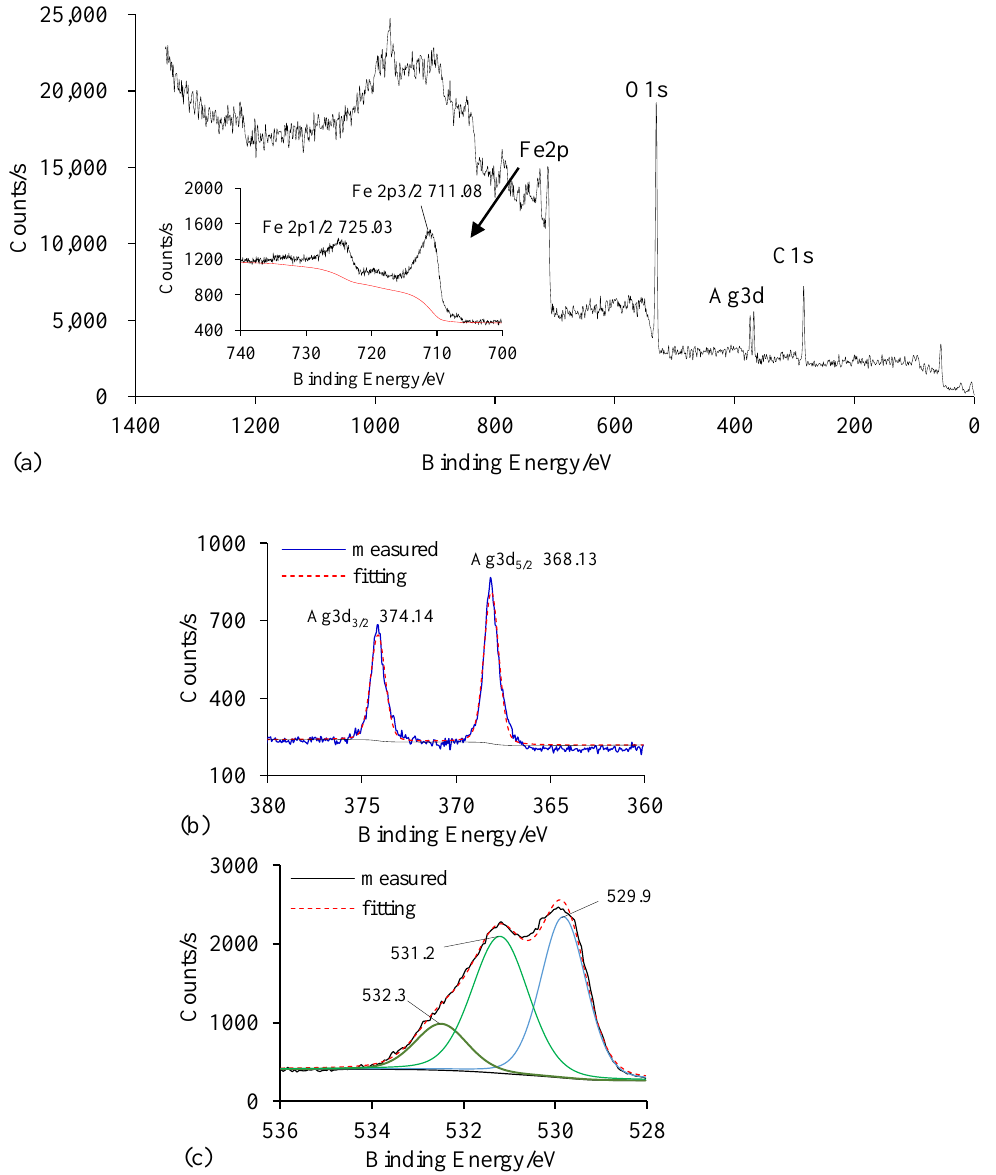
Figure 2. XPS wide-scan and high-resolution spectra of fresh Ag/Fe particle with 0.4 wt.% Ag loading. ( a ) Wide scan spectra of Ag/Fe; ( b )Ag 3d core level XPS spectra of Ag/Fe; ( c ) O1s core level XPS spectra of Ag/Fe.